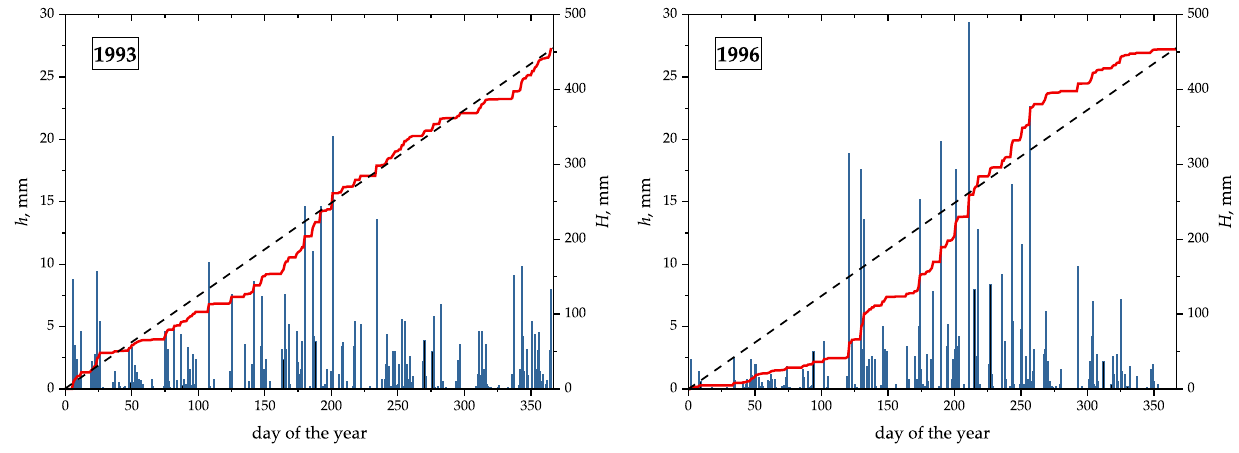
Fig. 6 Daily precipitation levels with the cumulative curve in Warsaw in 1993 and